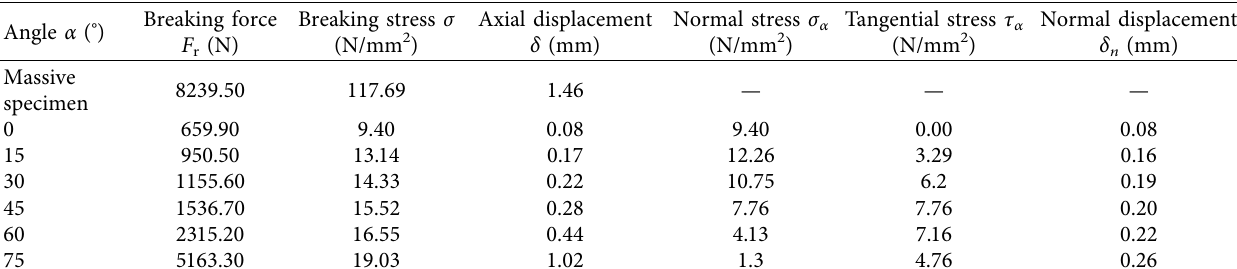
Table 4: Displacements ( δ n ), normal ( σ α ), and tangential ( τ α ) stresses as a function of the angle α .